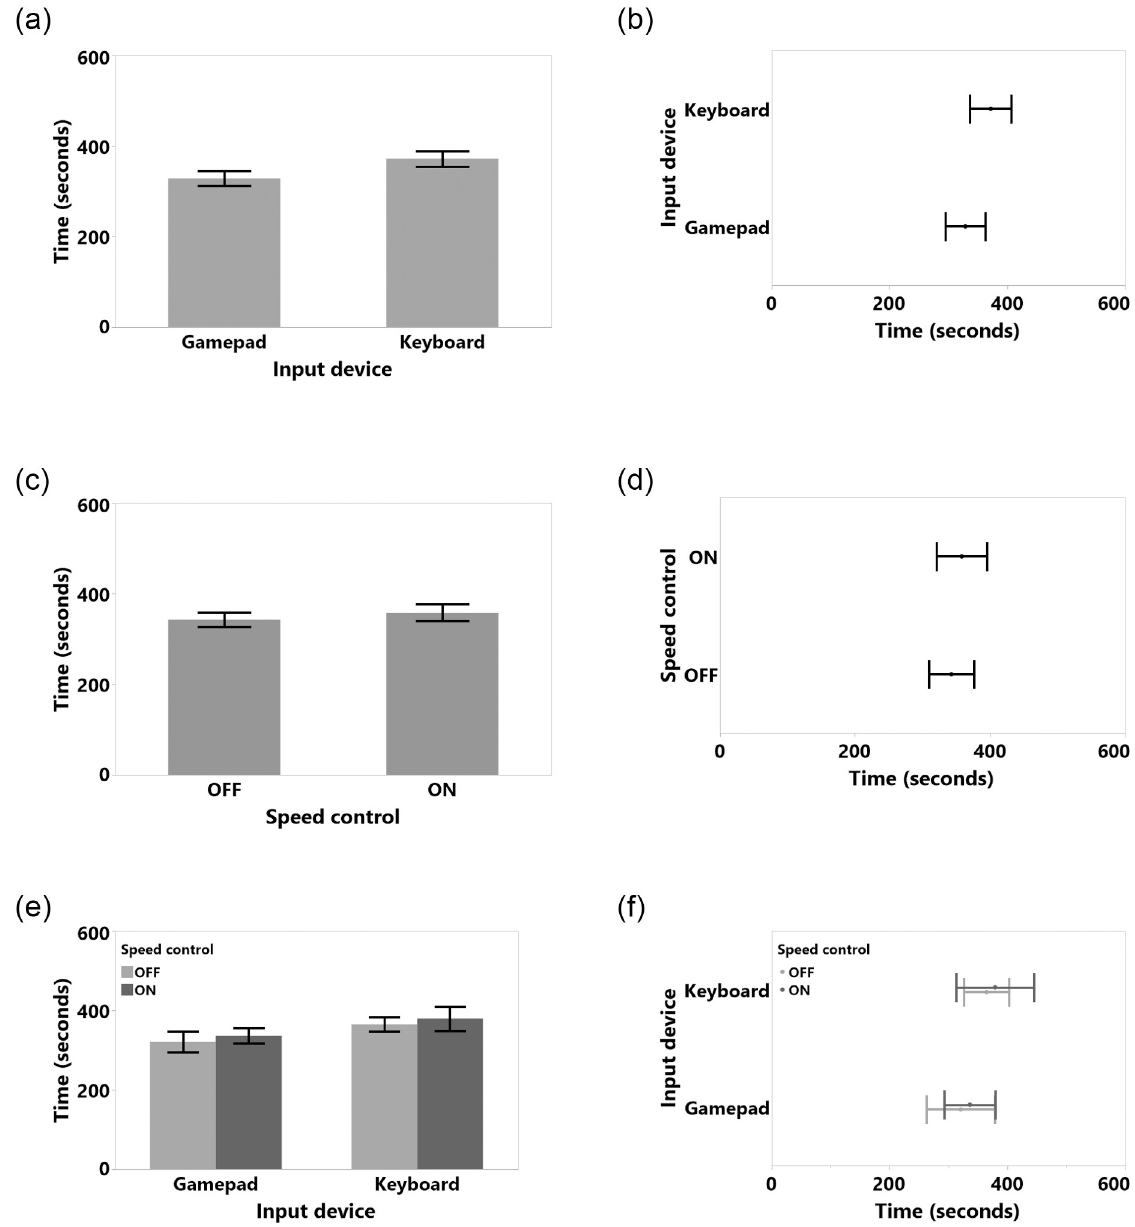
Fig 6. Task completion time means and standard error of means for (a) input device, (c) speed control, (e) input device and speed control interaction. Task completion time means and 95% confidence intervals for (b) input device, (d) speed control, (f) input device and speed control